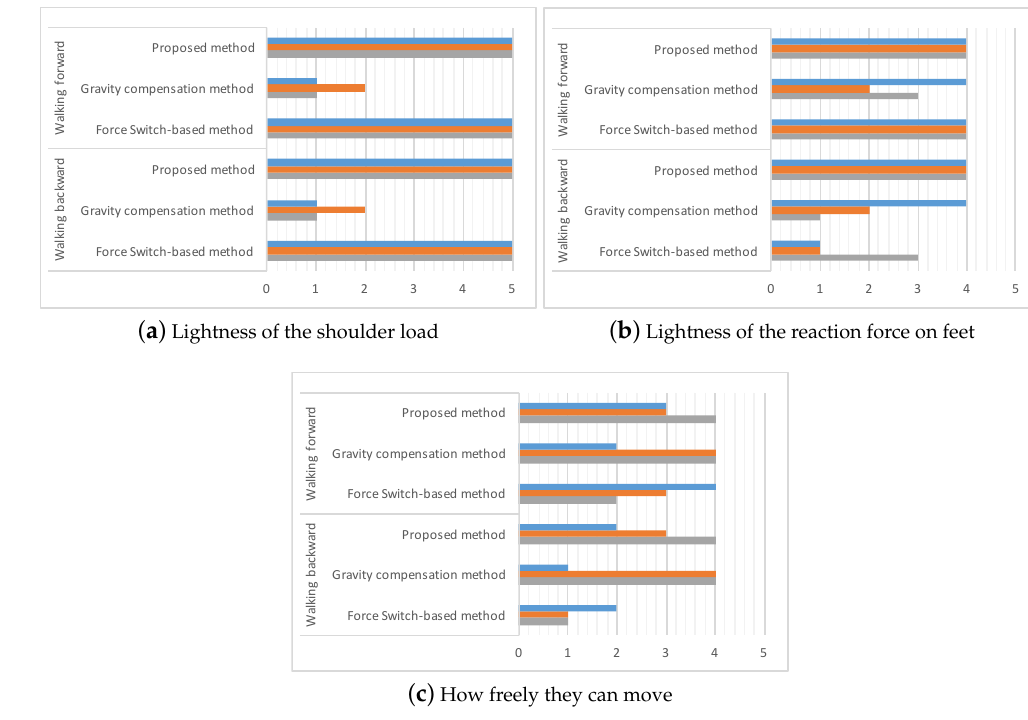
Figure 13. Answers to questionnaire on the powered exoskeleton controlled by the